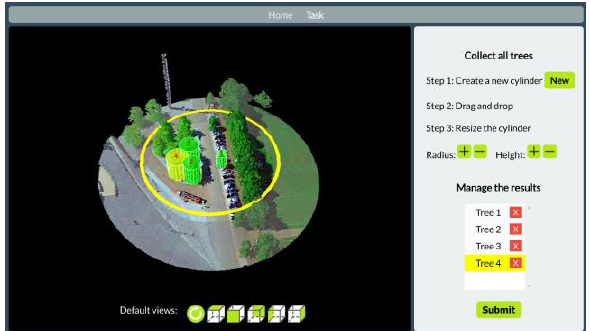
Figure 3. Web-tool for the crowd-based collection of trees from 3D point